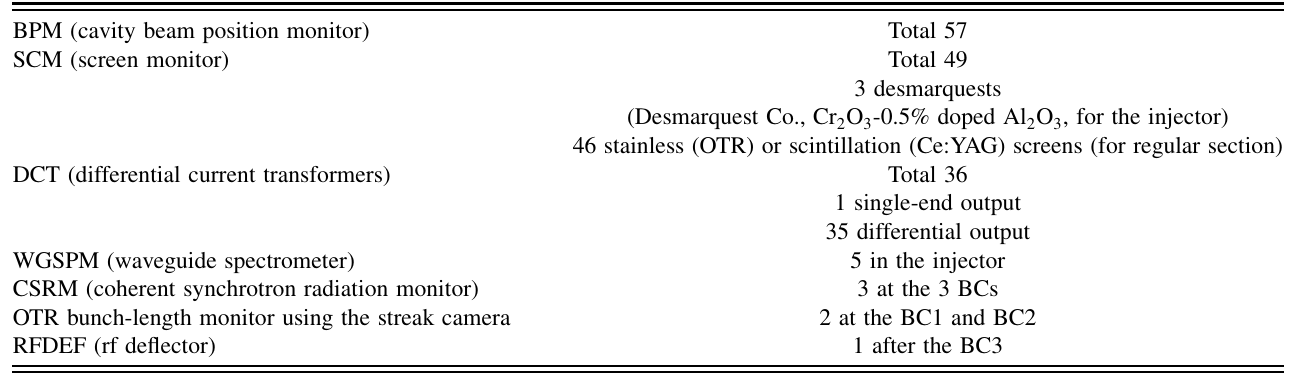
TABLE I. Kinds and numbers of beam monitors for SACLA.